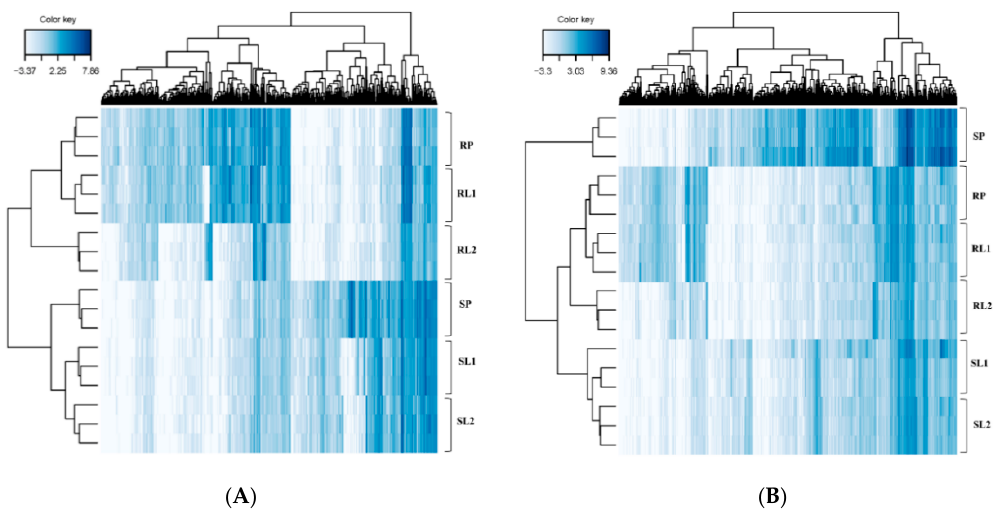
Figure 5. Heat map of different gene expression profiles ( ≥ 1.5-fold, FDR ≤ 0.05) of resistant/susceptible genotypes after infection with STB at ( A ) 10 dpi and ( B ) 12 dpi. SP—susceptible parent, RP—resistant parent, SL1—susceptible line 1, SL2—susceptible line 2, RL1—resistant line 1 and RL2—resistant line